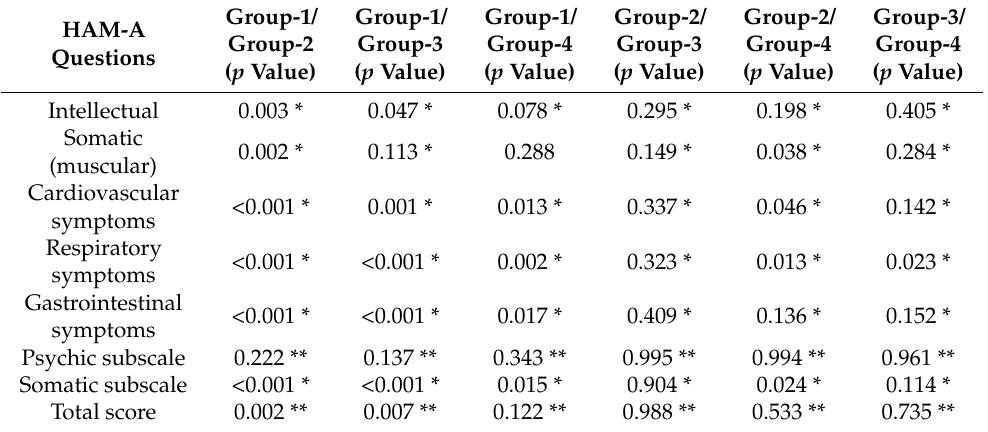
Table 3. Comparisons between HAM-A questions, subscales and total score in different pathologies.